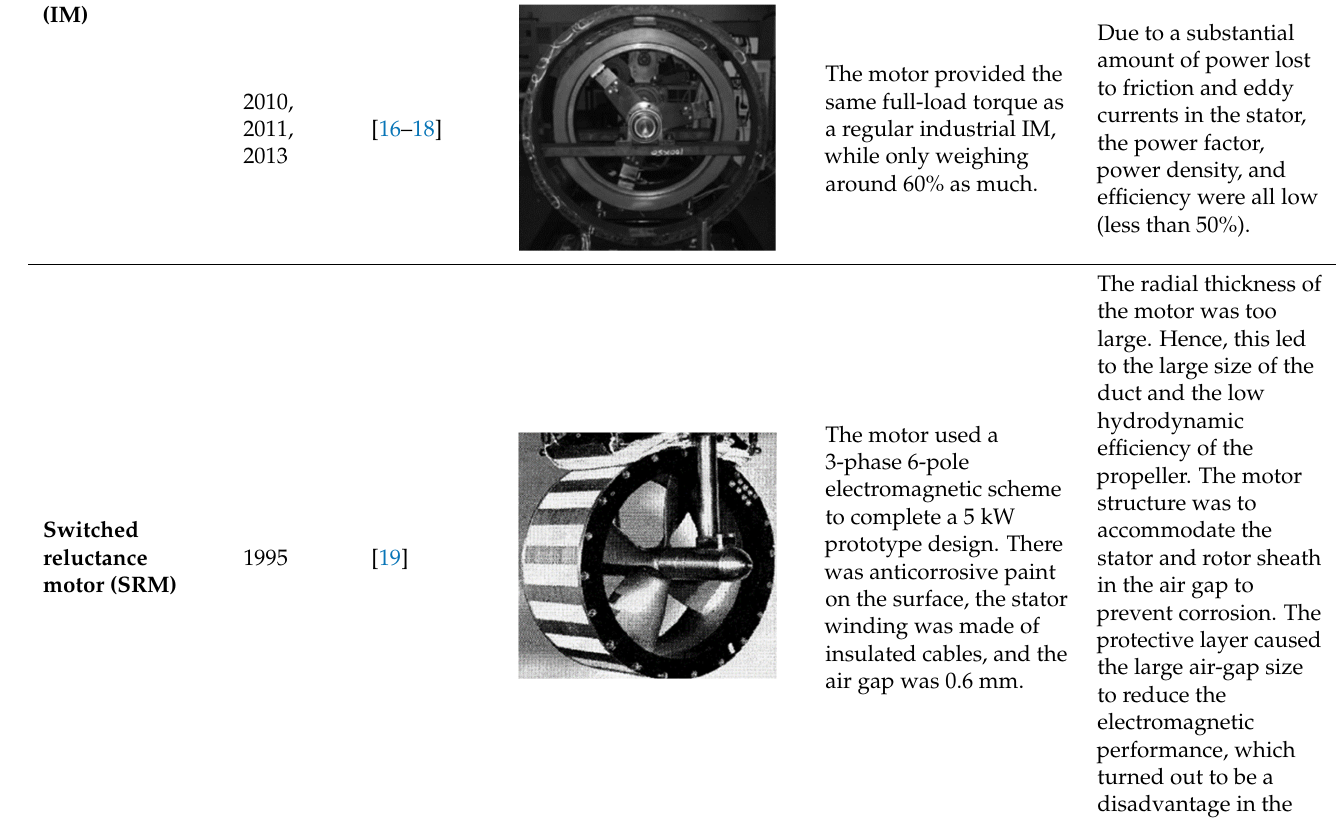
Table 1. Types of electric motors applicable to